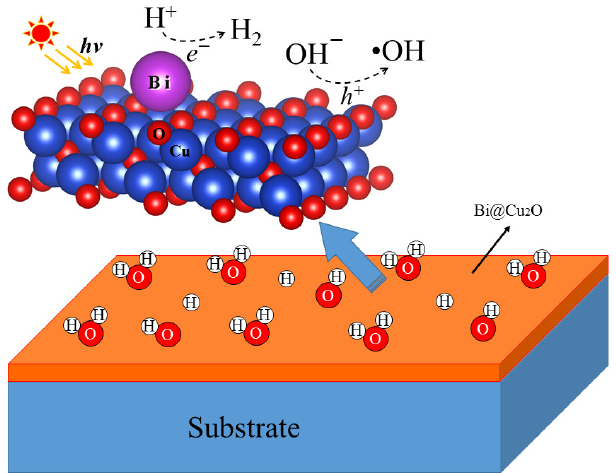
Figure 5. The photocatalytic oxidation and reduction on the Cu 2 O(100)